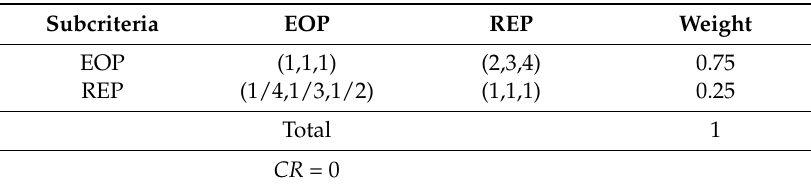
Table A19. Comparison matrix for PUS.